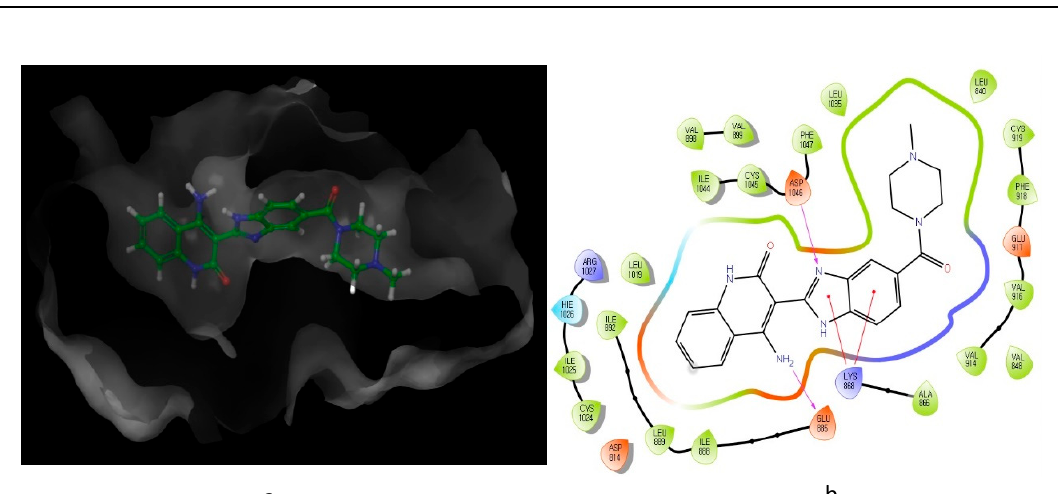
Figure 4. Predicted interaction of α -sulfone ( 12 ) derivative active site residues of matrix metalloproteinase (MMP) [51,52]. ( a ) 3D structural view of ligand inside the receptor’s active site. ( b ) Ligand interaction diagram; violet lines represent hydrogen bonds and green lines and grey line represent metal interactions.